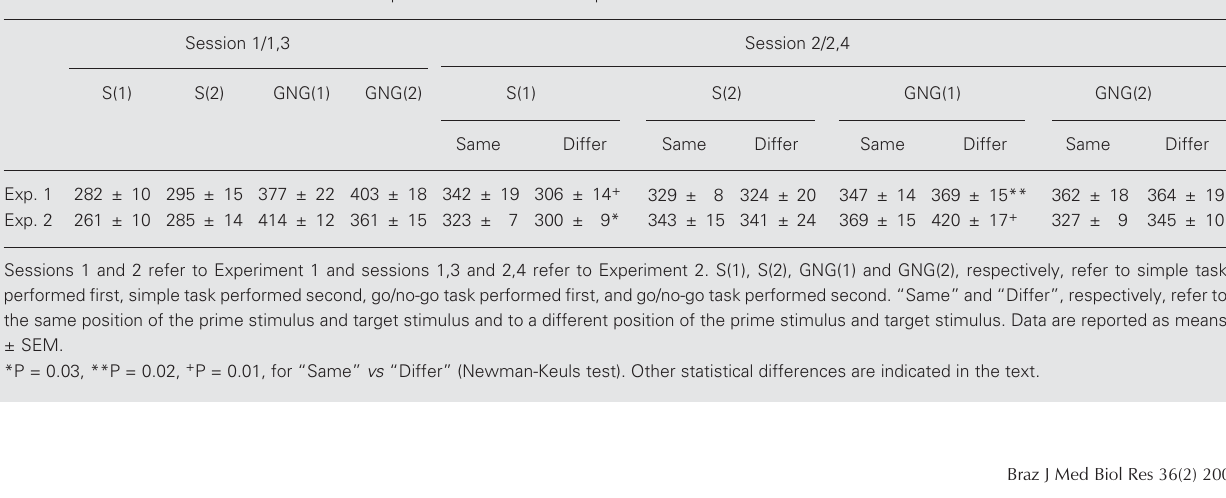
Table 1. Reaction time in milliseconds for each experimental condition of Experiments 1 and